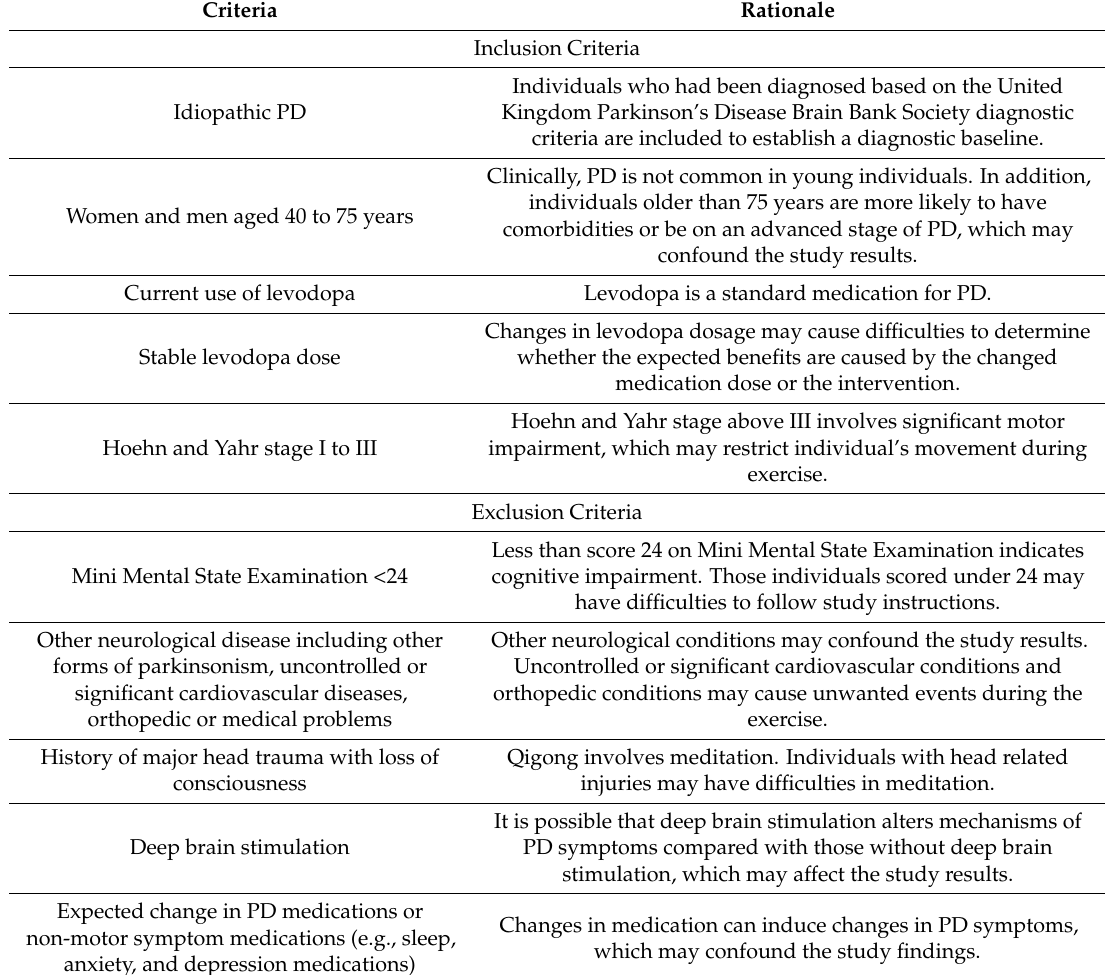
Table 1. Inclusion and exclusion criteria and